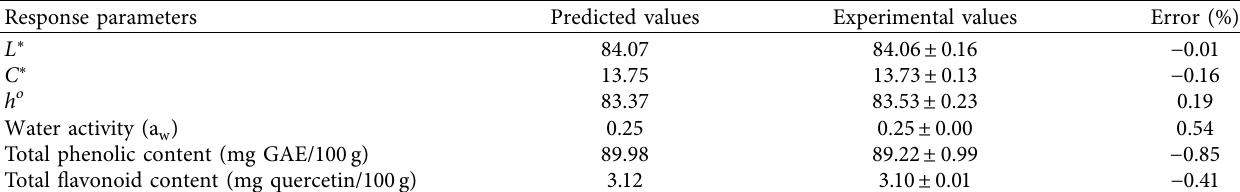
Table 4: Validation of predicted results at optimum tray-drying